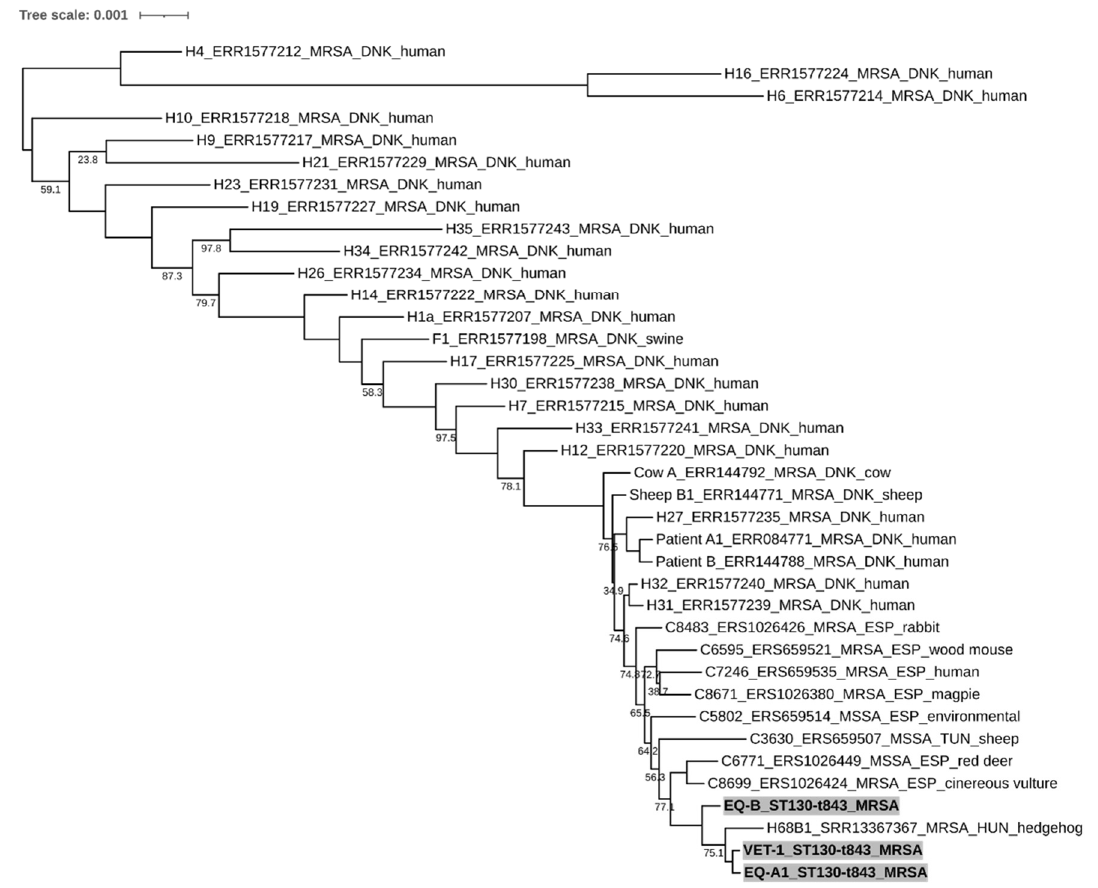
Figure 4. Neighbour-joining tree from the SNP-based phylogenetic analysis. The phylogenetic relationship between the two equine (EQ-A1, EQ-B) and the human (VET-1) originated mecC -positive isolates from Hungary (highlighted with grey background) in comparison of other selected 32 mecC - positive MRSA and three MSSA CC130 isolates from Europe (Denmark (DNK), Hungary (HUN), Spain (ESP), and Tunisia (TUN)). The scale bar indicates number and type of substitutions. Only bootstrap values lower than 100 are shown. (For further details, see Appendix A and Table S3).